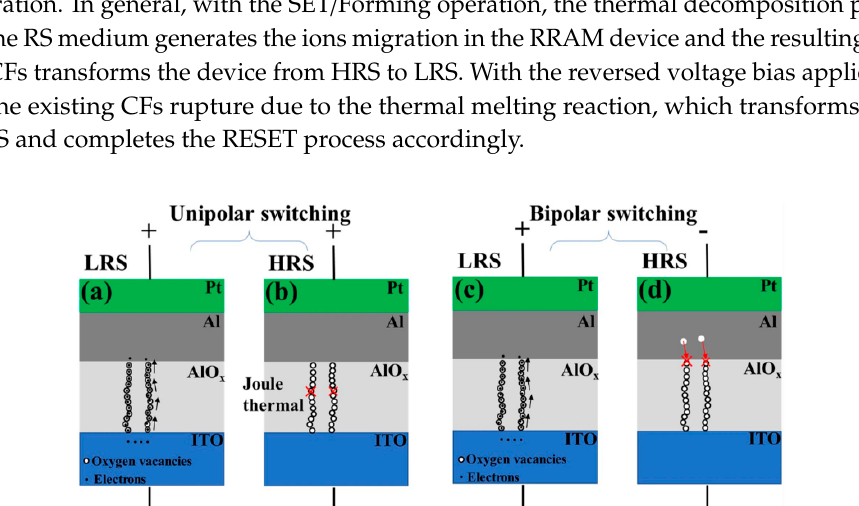
Figure 3. Switching mechanism of unipolar ( a ) ( b ) and bipolar ( c ) ( d ) AlO x -based RRAM devices, reproduced from [39], with permission from Springer Nature, 2020.